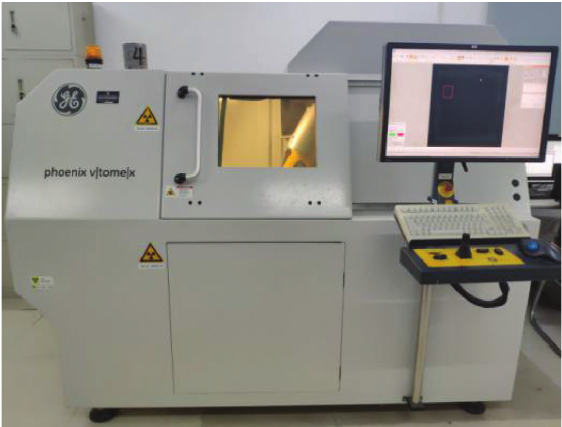
Figure 2: Industrial CT scanning test device.